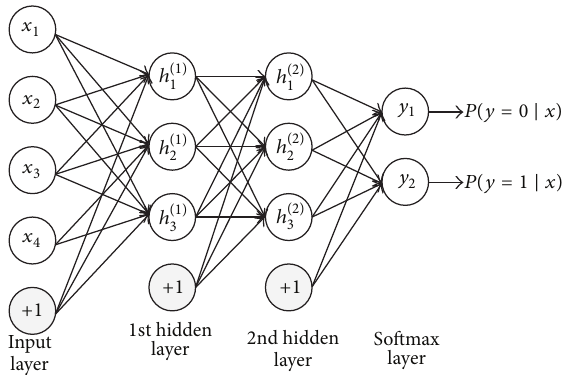
Figure 6: Stacked autoencoder with softmax